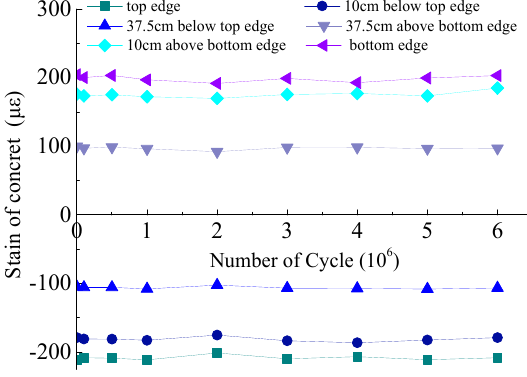
Figure 14. Concrete stain development at midspan.